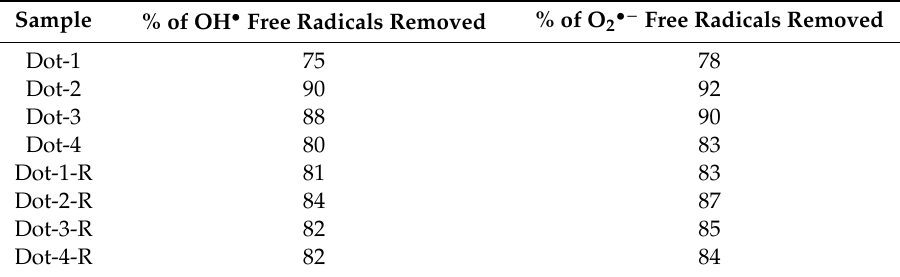
Table 3. Antioxidant properties of the prepared